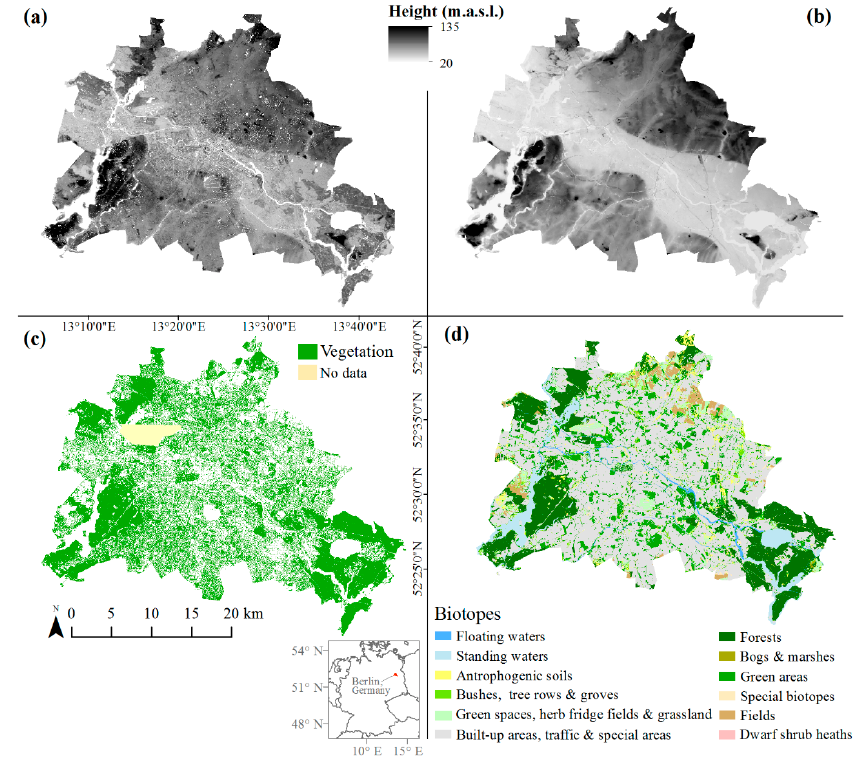
Figure 2. ( a ) TanDEM-X intermediate DEM; ( b ) LiDAR DTM; ( c ) UltraCamX vegetation layer; ( d )